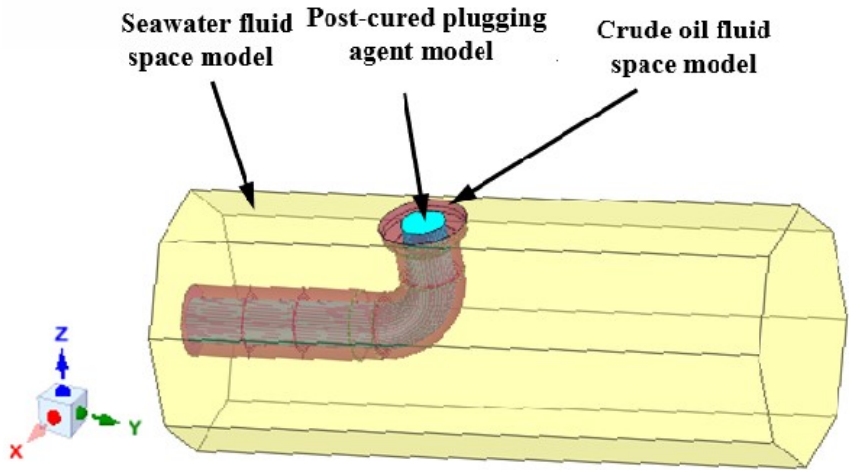
Figure 4. Seawater and petroleum oil fl ow fi eld spatial model.